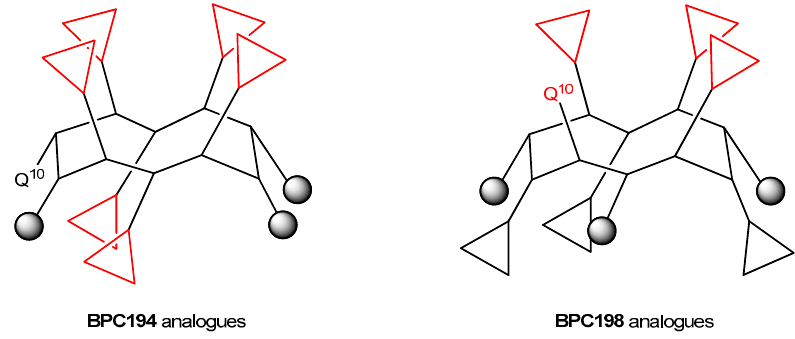
Figure 8. General structure of the active conformation of BPC194 and BPC198 analogues. Triangles stand for hydrophilic Lys residues and grey circles stand for hydrophobic Leu or Phe residues.